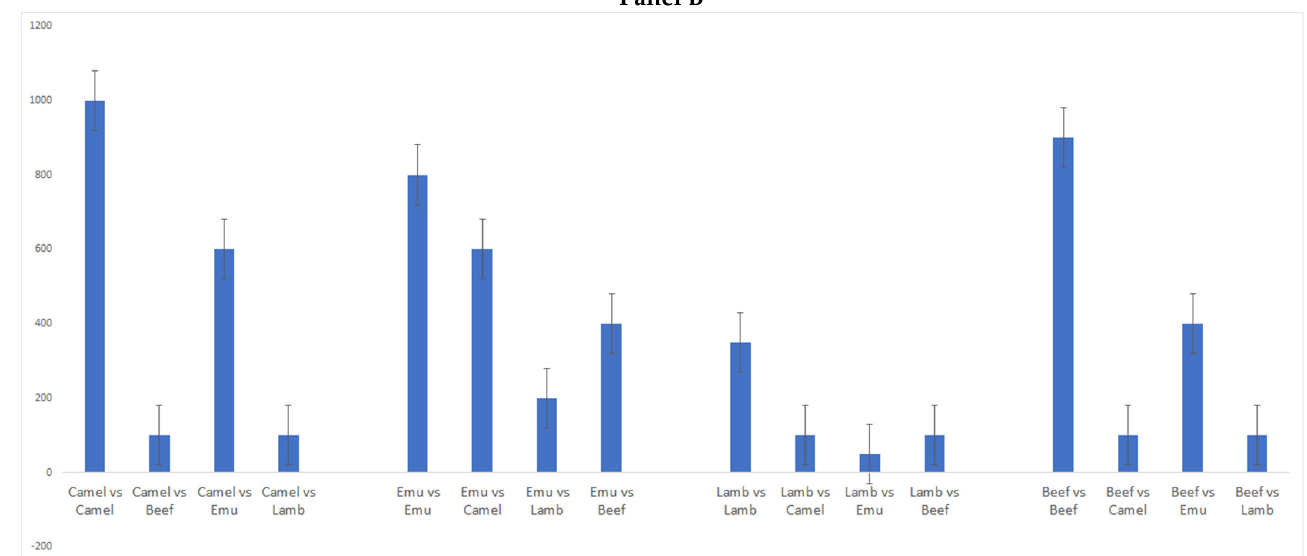
Figure 4. Similarity index calculated for the minced meat samples of lamb ( Ovis aries ), emu ( Dromaius novaehollandiae ), camel ( Camelus dromedarius ), and beef ( Bos taurus ) analyzed using a portable NIR instrument. ( Panel A ): whole range (950 to 1600 nm); ( Panel B ): lipid and protein range (1200 to 1400 nm).